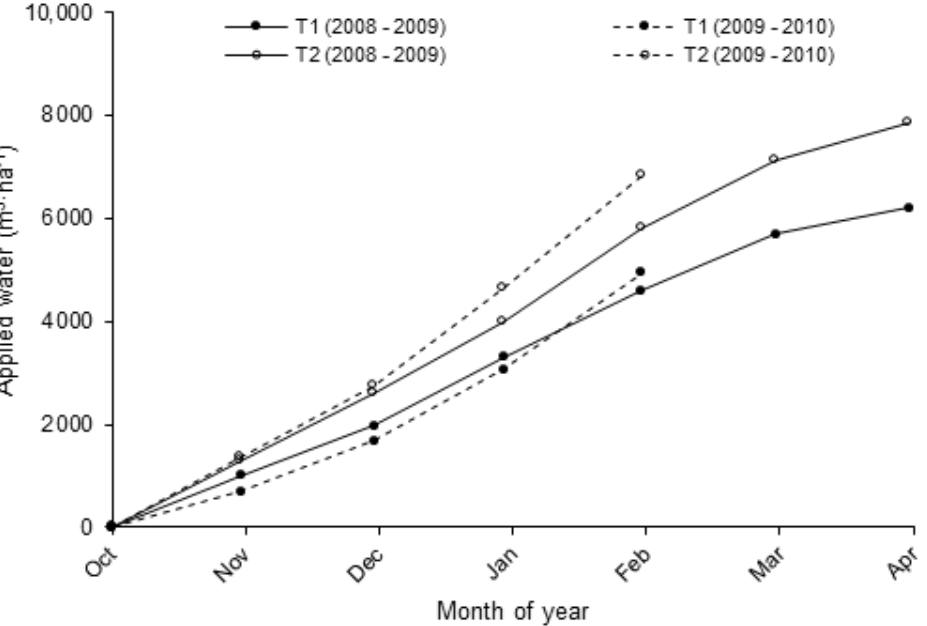
Figure 3. Cumulative applied water during the 2008 – 2009 and 2009 – 2010 irrigation seasons in two water application treatments via microjet irrigation of ‘Royal Gala’ apple trees. T1: Irrigation with theoretical volume of water required by the plant. T2: Irrigation with farm protocol.